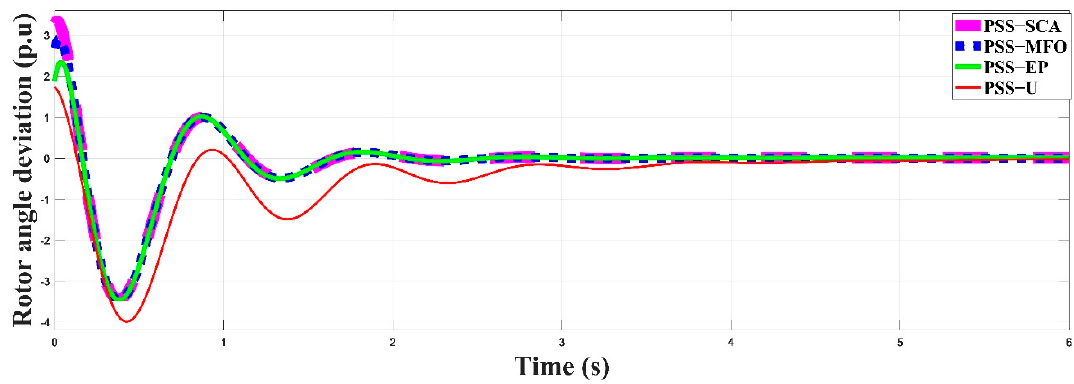
Figure 7. Rotor angle deviation response of PSSSCA, PSSMFO, PSS-EP, and PSS-U for case 1. All eigenvalues are on the negative side of the complex s-plane, showing the stable condition of all systems for case 1, as shown in Figure 8. The eigenvalues of PSS-SCA are on the left-most of the imaginary axis of the s-plane and are shifted towards the real axis of the s-plane compared with those of the other techniques.